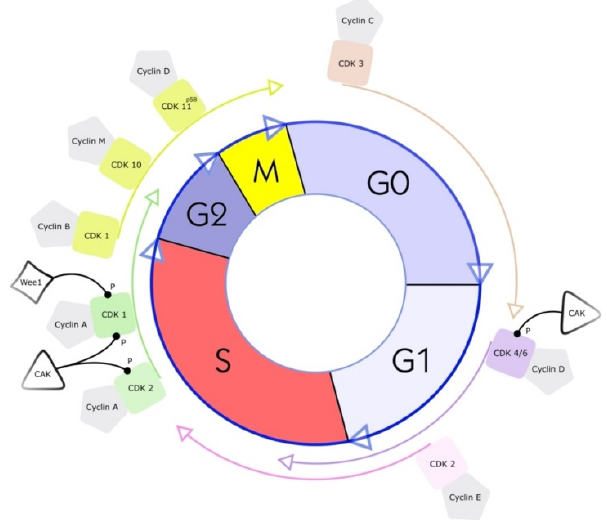
Figure 1. Cell cycle and a simplified illustration of interactions with selected kinases and cyclins. G1 is the cell cycle phase; in this phase, the cell increases in volume, but mitosis has not yet taken place. It is the first part of the interphase and transition into the S phase, the cell cycle’s replication phase. DNA replication takes place in this phase. The S phase (2nd phase) is usually constant in time (about 7 to 8 h) and lies between the G1 and G2 phases. Third, the G2 phase of the cell cycle is the second part of the interphase. It follows the S phase and enters the prophase of mitosis, in which the cell’s chromatin condenses into chromosomes. The following M phase describes the division of the cell. The nucleus splits (mitosis), and the entire cell divides (cytokinesis). Finally, the facultative G0 phase is the cell-cycle stage in which dormant or differentiated cells (e.g., nerve and muscle cells) are found